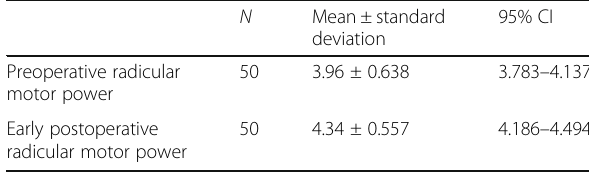
N Mean ± standard 95% CI deviation